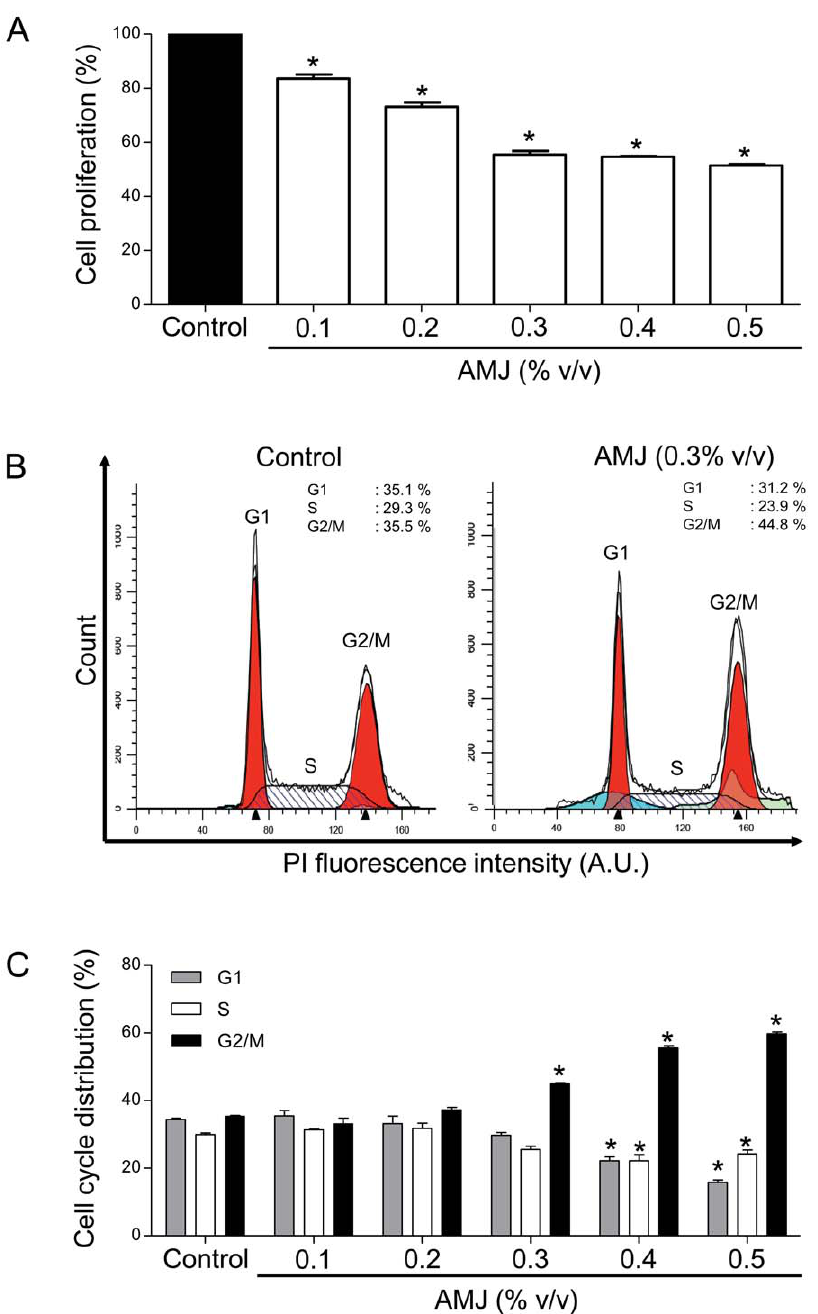
Figure 1. AMJ caused a concentration-dependent inhibition of cell proliferation and induction of G2/M cell cycle arrest in Jurkat cells. Cells were exposed to increasing concentrations of AMJ for 24 h. (A) cell proliferation rate was determined using MTS assay. The absolute value obtained for each AMJ-treated sample is expressed as percent relative to the absolute value obtained for the untreated sample and set at 100%. (B) and (C) cell cycle distribution was assessed by flow cytometry using the DNA fluorochrome PI detection assay. (B) shows representative DNA content histograms for treated (right panel) or untreated (left panel) cells. (C) Corresponding cumulative data. The number of cells in each mitosis phase is determined and expressed as percent relative to the total cell number. Values are shown as means 6 S.E.M. (n=3); *, P , 0.05 versus respective control.